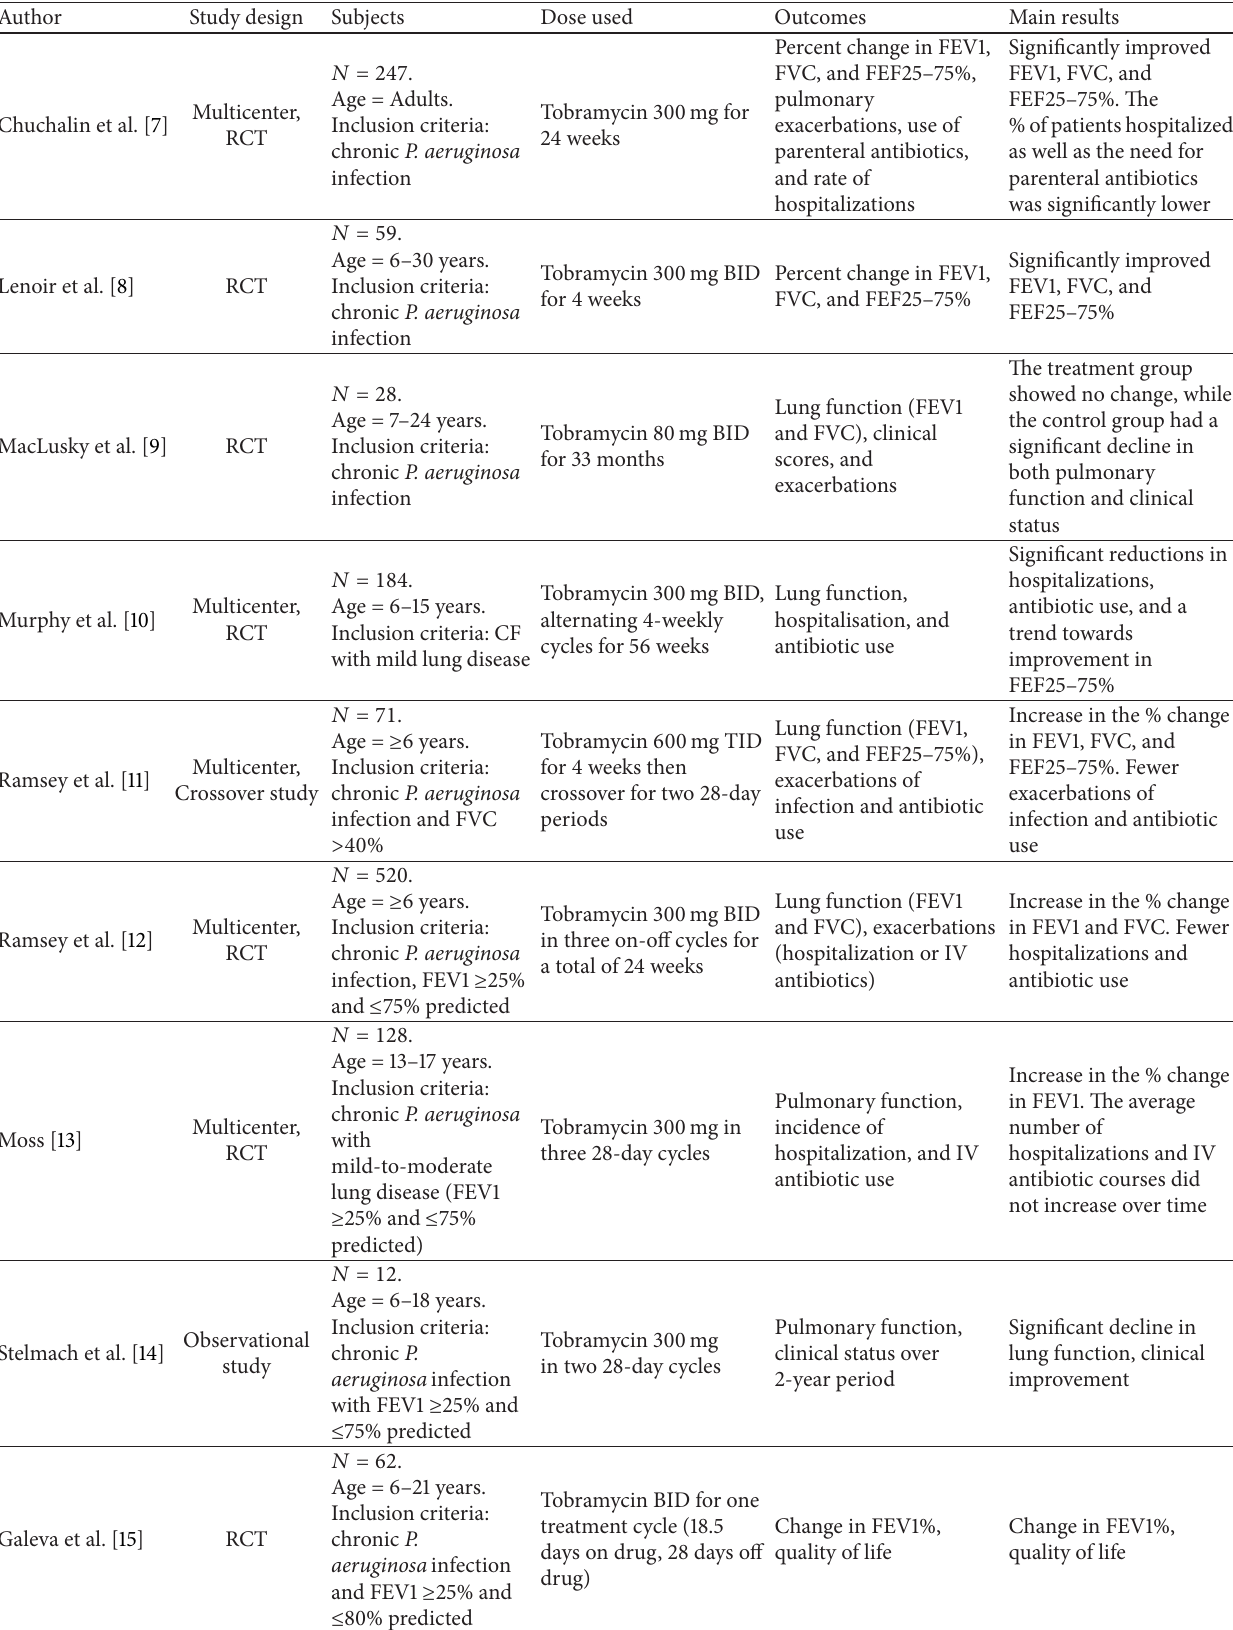
Table 2: Summary of TIS/TSI